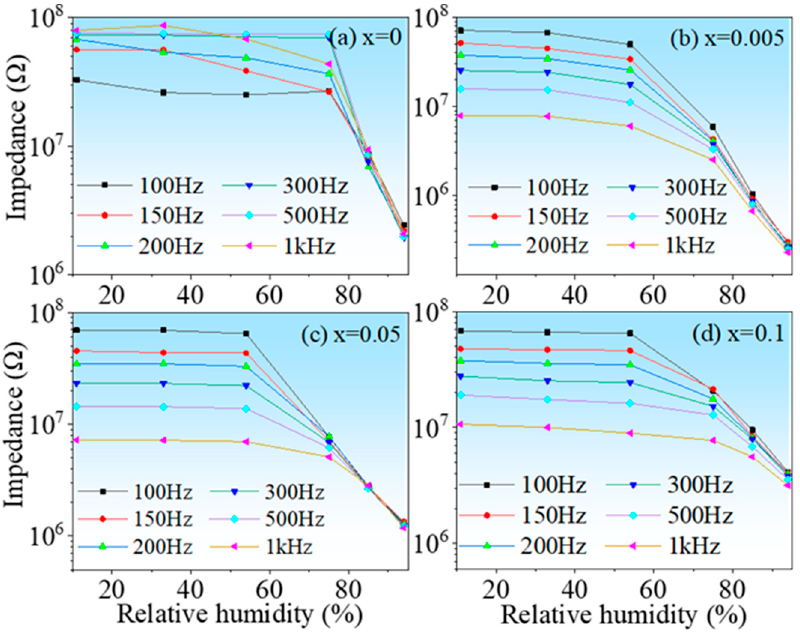
Figure 5. ( a – d ) Impedance as function of RH level of the ceramic samples.